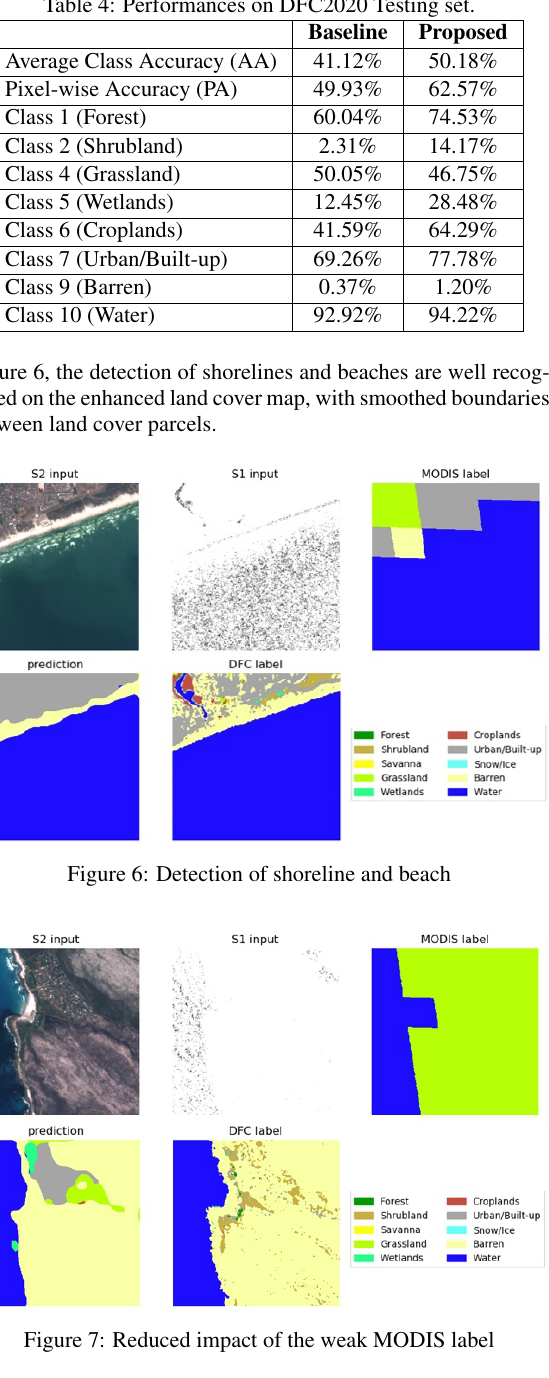
Table 4: Performances on DFC2020 Testing set.